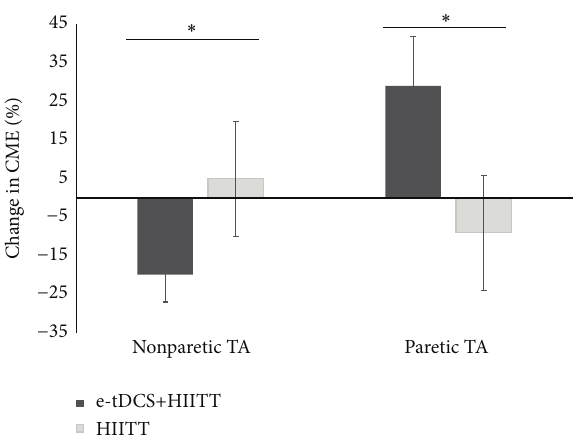
Figure 3: Percentage change in corticomotor excitability (CME) for the e-tDCS+HIITT (dark bars) and HIITT (light bars) groups. Corticomotorexcitabilitywasexaminedbycalculatingthechangein linear slopes of the TMS recruitment curve before and after training for the bilateral tibialis anterior (TA) muscles. There were significant differences between the groups for the nonparetic and paretic TA muscles. ∗ 𝑝 < 0.05 .